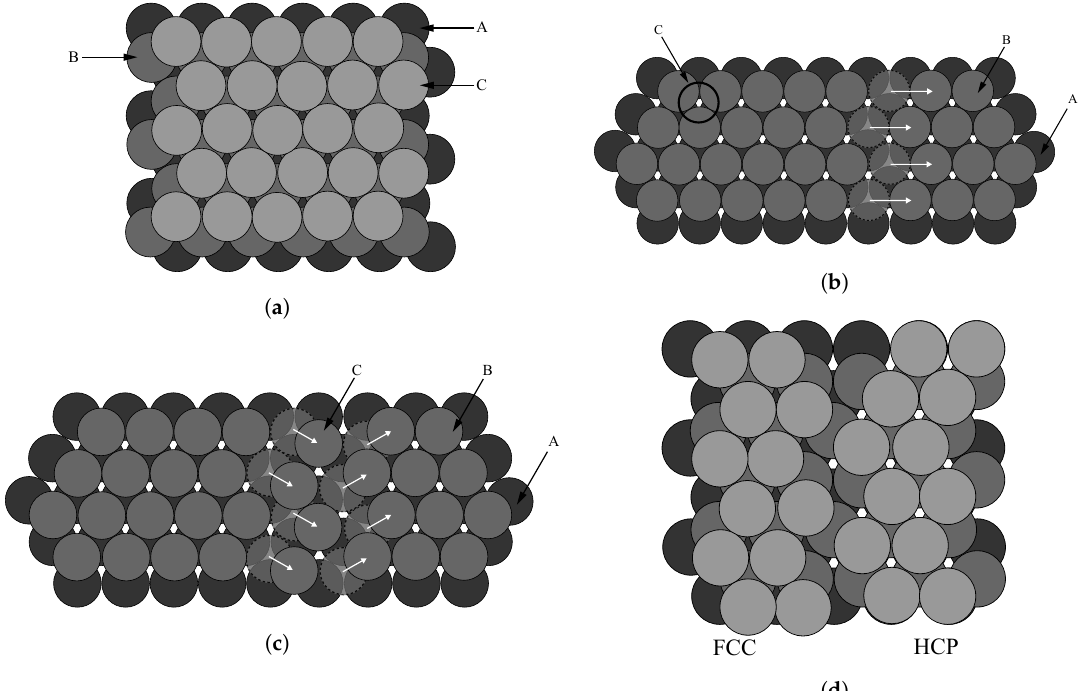
Figure 1. The FCC lattice with: ( a ) ABCABC stacking arrangement, ( b ) perfect dislocations, ( c ) partial dislocations, and ( d ) hexagonal close-packed (HCP) lattices due to partial dislocations [7].